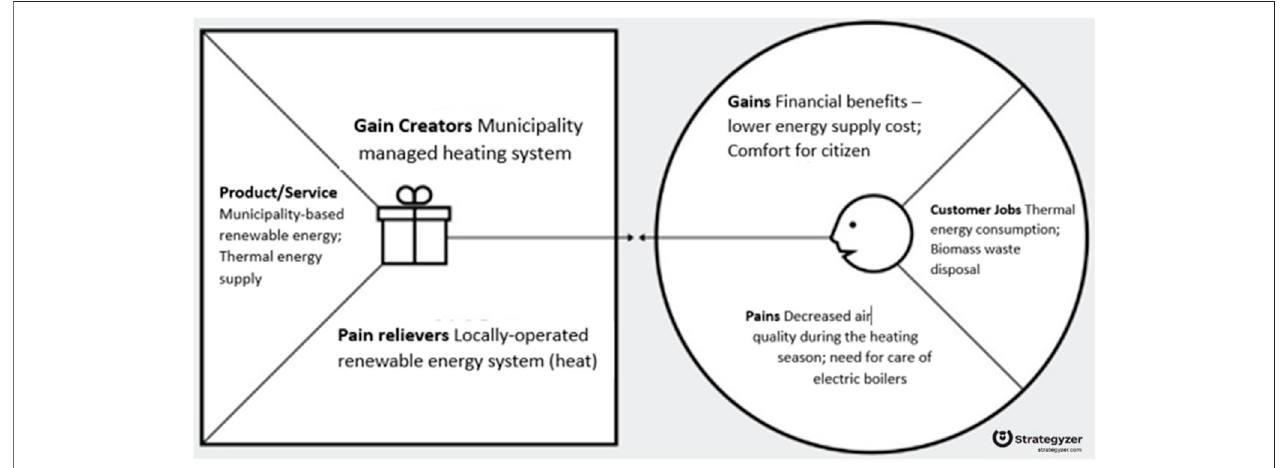
FIGURE 2 | Value proposition canvas (municipality-based) based on Osterwalder et al. (2014), Strategyzer.com, and with copyright by Strategyzer